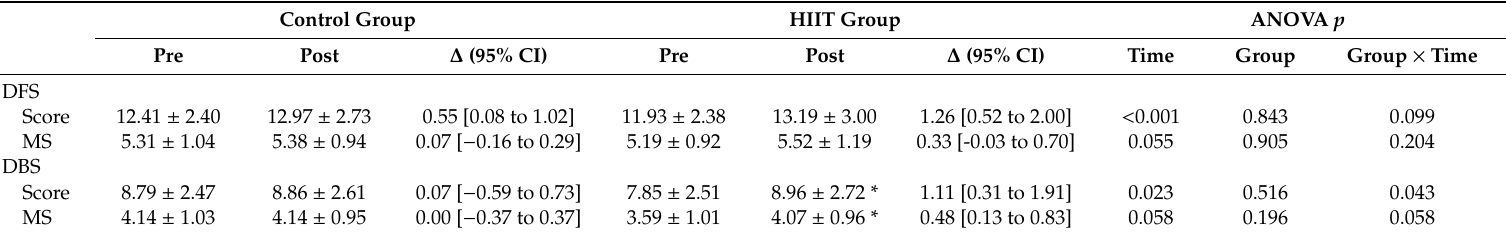
Table 3. Changes in the digit span test after training intervention.